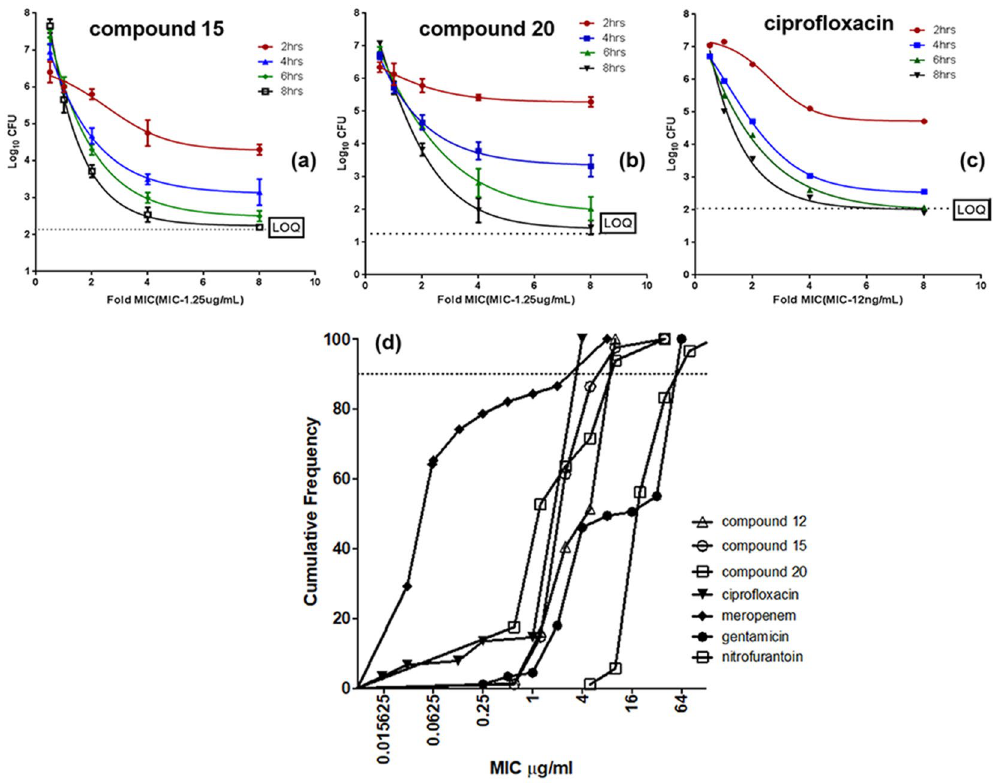
Figure 4. In vitro Time kill analysis of the compounds 15 ( a ), 20 ( b ) & ciprofloxacin ( c ) against E. coli BW24113. ( d ) MIC90 analysis of compounds 12, 15 & 20, along with standard drugs for a collection of recent uncharacterised clinical isolates of E. coli (St. John’s Medical Hospital, Bengaluru,